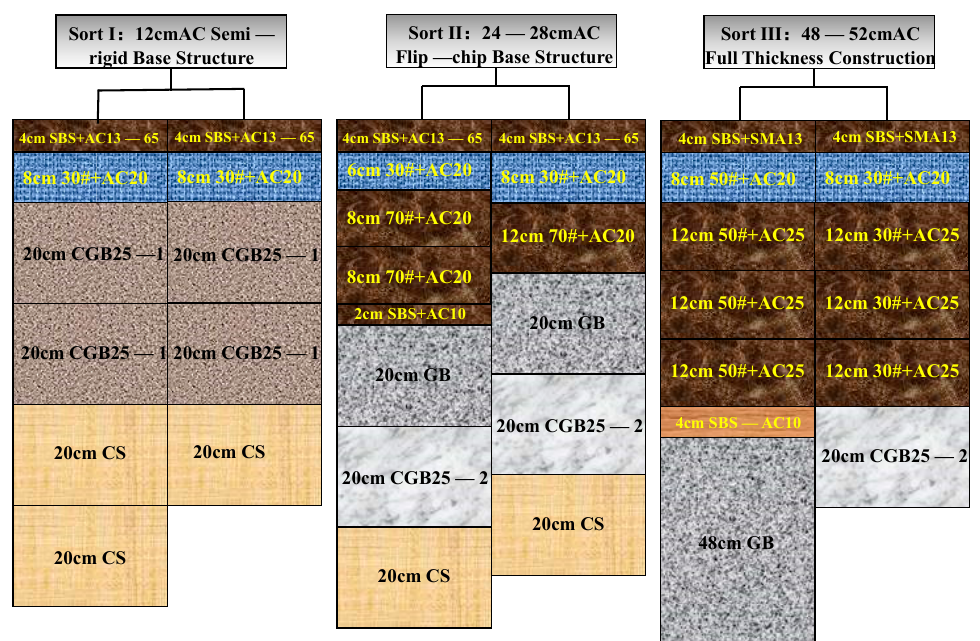
Figure 1. Pavement core sample.